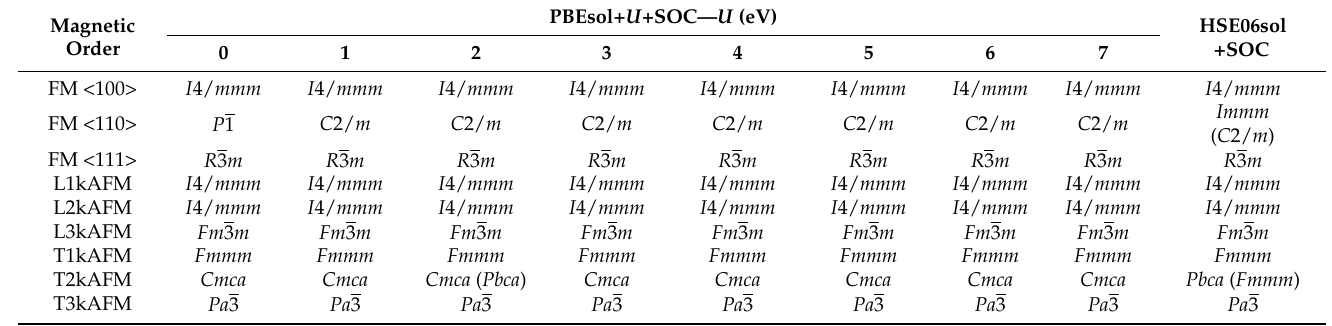
Table 1. Space groups calculated with HSE06sol+SOC and PBEsol+ U +SOC with a tolerance of 10 − 5 Å for FM <100>, <110> and <111>, longitudinal and transverse AFM 1k, 2k and 3k order for cubic PuH 2 . For cubic PuH 3 , the space groups are the same apart from the ones in brackets, which refers to the space group for PuH 3 when it differs from that of PuH 2 . Space group numbers: I 4/ mmm (139), P 1 (2), C 2/ m (12), Immm (71), R 3 m (166), Fm 3 m (225), Fmmm (69), Cmca (64), Pbca (61) and Pa 3